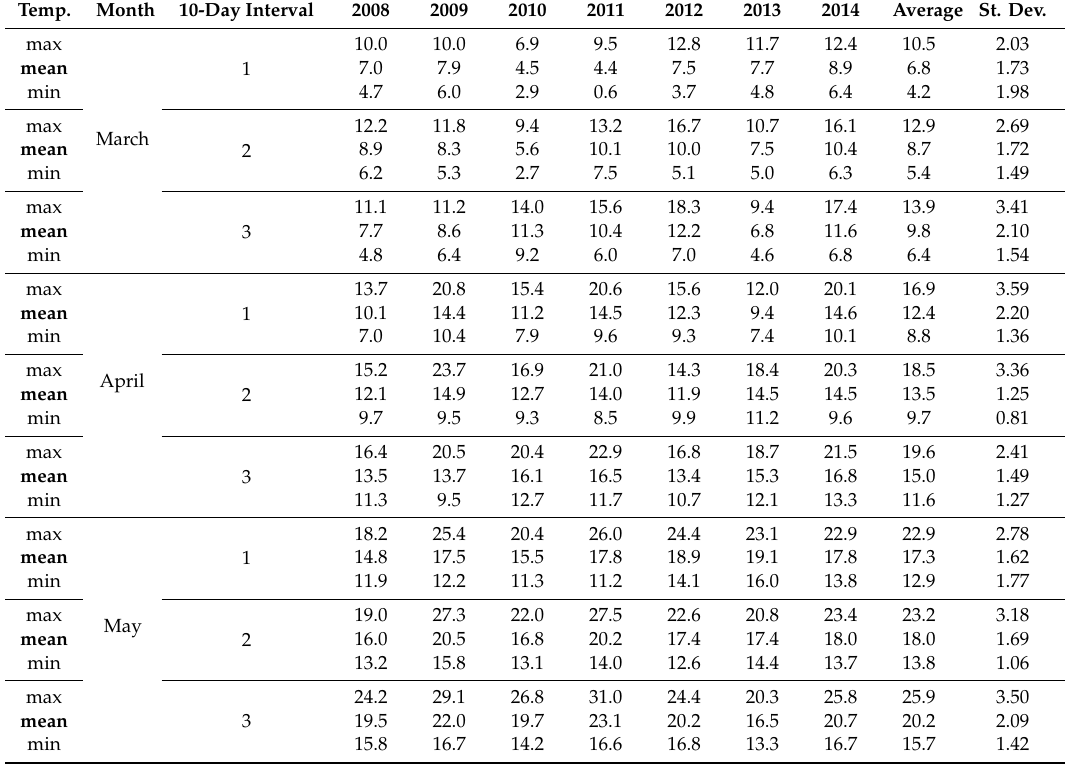
Table 1. Ten-day average of maximum, minimum, and mean daily temperatures ( ◦ C) in Legnaro (Padova, Italy) for the period 2008–2014, and averages and standard deviations over the seven years. Temp. Month 10-Day